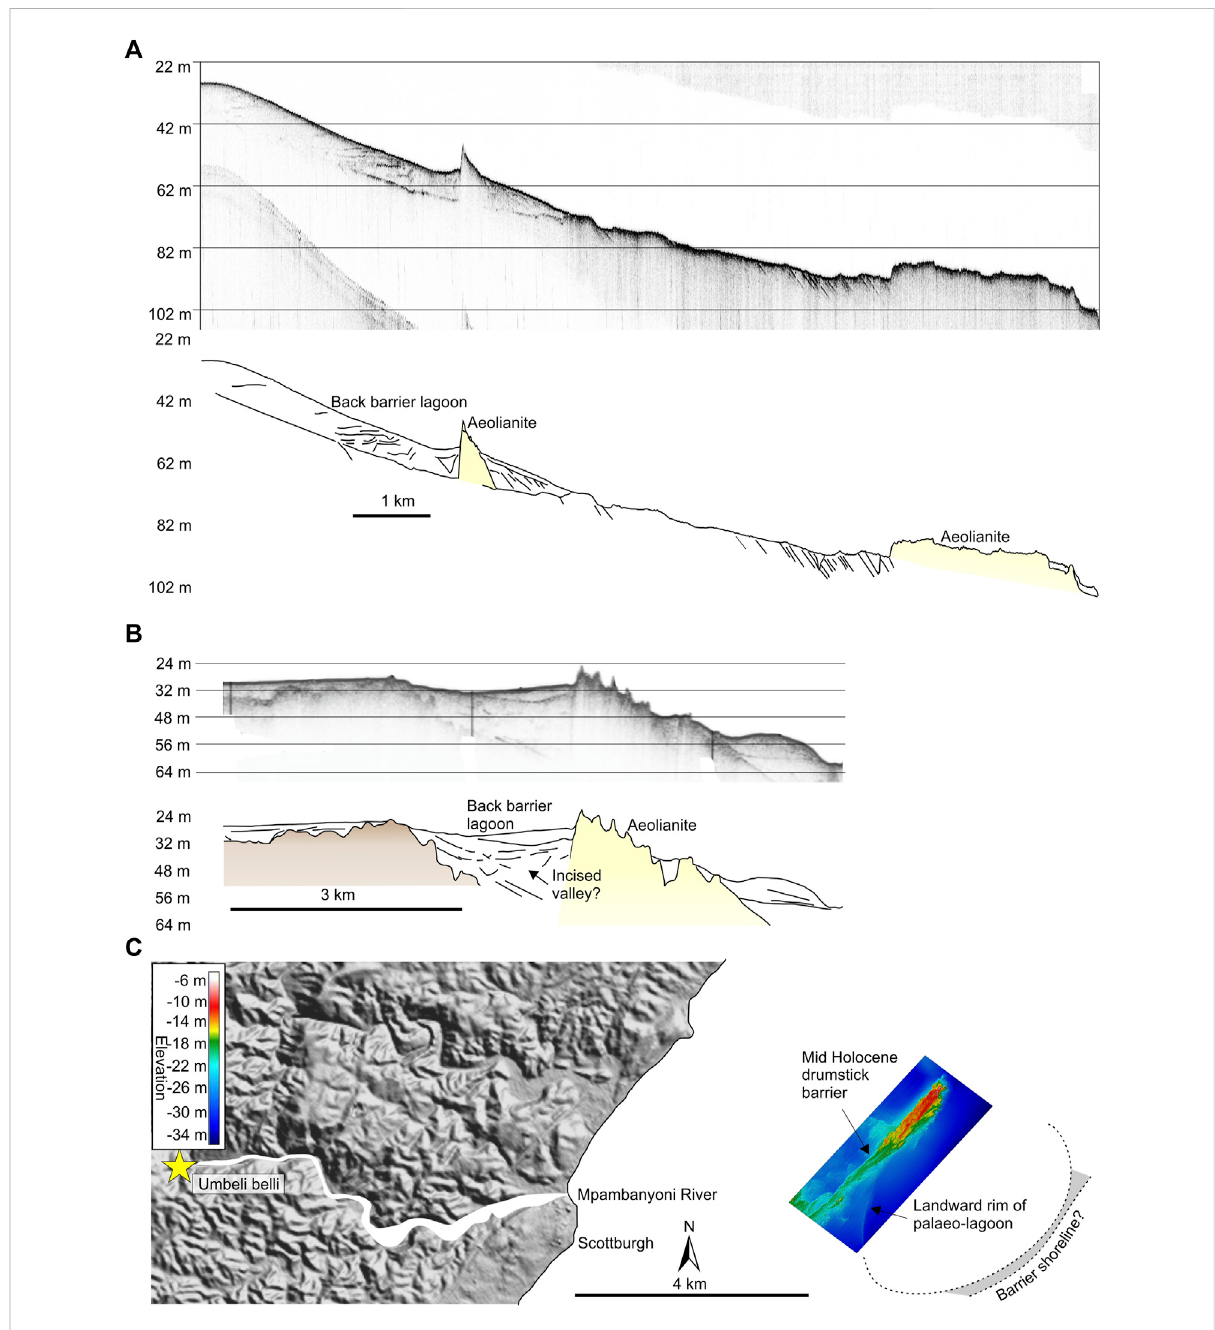
FIGURE 10 (A) Seismicre fl ectionpro fi lefromtheKZNsouthcoastoffshoreMtwalume.Notethetwoclearphasesofaeolianitedevelopmentat-100 mand 60 m. There is a prominent back barrier lagoon complex housed behind the 60 m shoreline. (B) Seismic re fl ection pro fi le offshore the Amanzimtoti area.Notethesimilarseismicarchitectureto (A) DataadaptedfromGribble(2021). (C) MultibeambathymetryoftheAliwalShoal,juxtaposedwiththe location of Umbeli Belli. The shoal forms a drumstick barrier, fringed to seaward by an arcuate ridge that we interpret as the landward rim of a